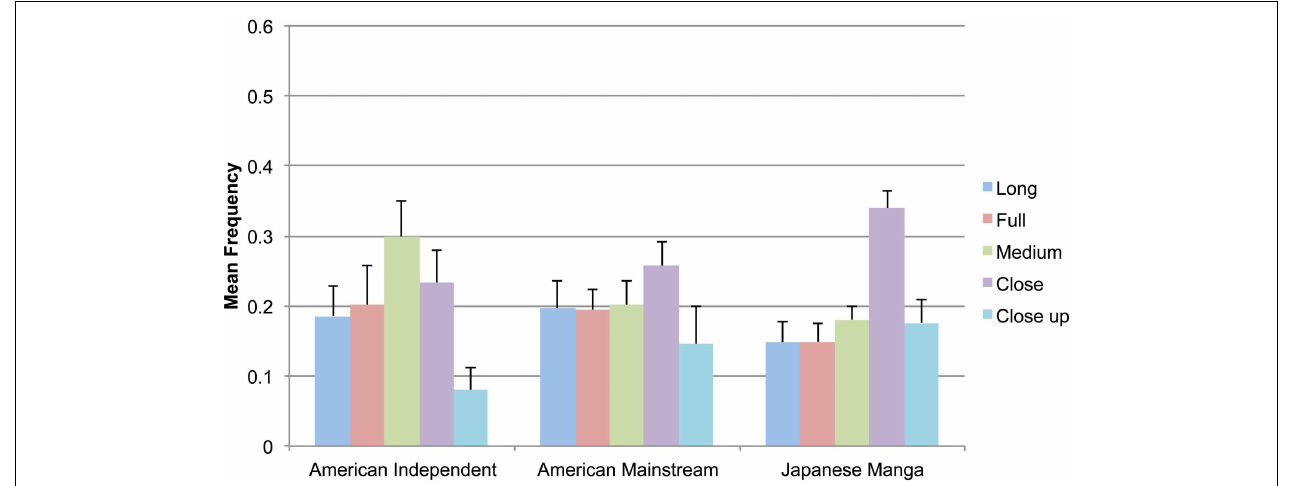
FIGURE 5 | Mean frequency of types of filmic shots inAmerican Independent and Mainstream comics and Japanese